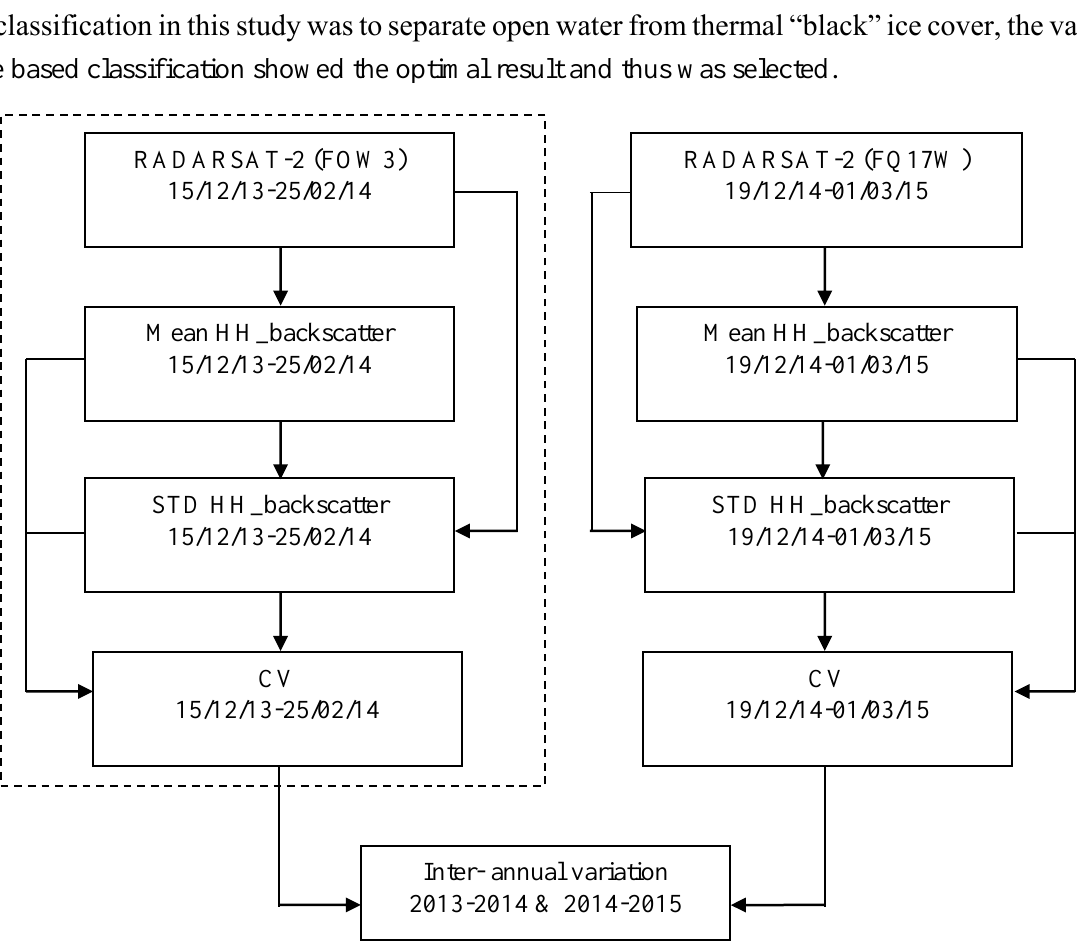
Figure 5. Analyzing the process of spatio-temporal variation in the ice cover in the 2013–2014 and 2014–2015 winters. A similar process of CV calculation (dash box) was applied to RADARSAT-2 (FOW3) images acquired from November 2013 to February 2014, to monitor intra-annual variation of ice cover of the 2013–2014 winter (13 November–14